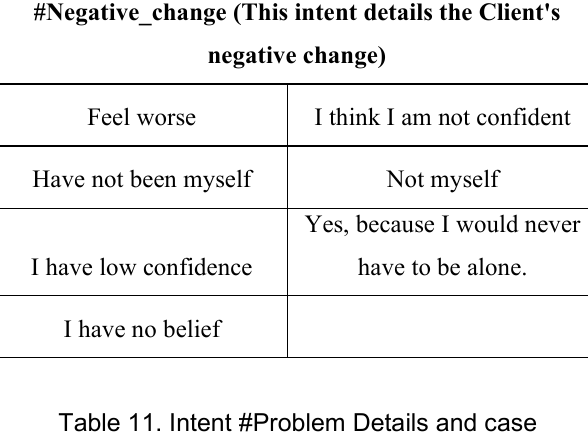
Table 11. Intent #Problem Details and case examples configured